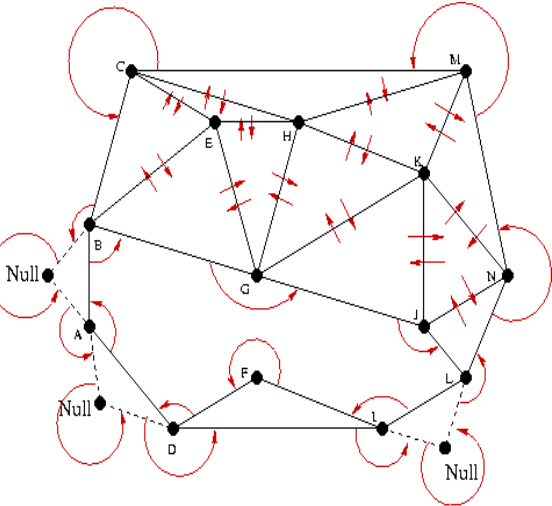
Figure 23. Representation of the implementation of the Delaunay algorithm for triangulation.